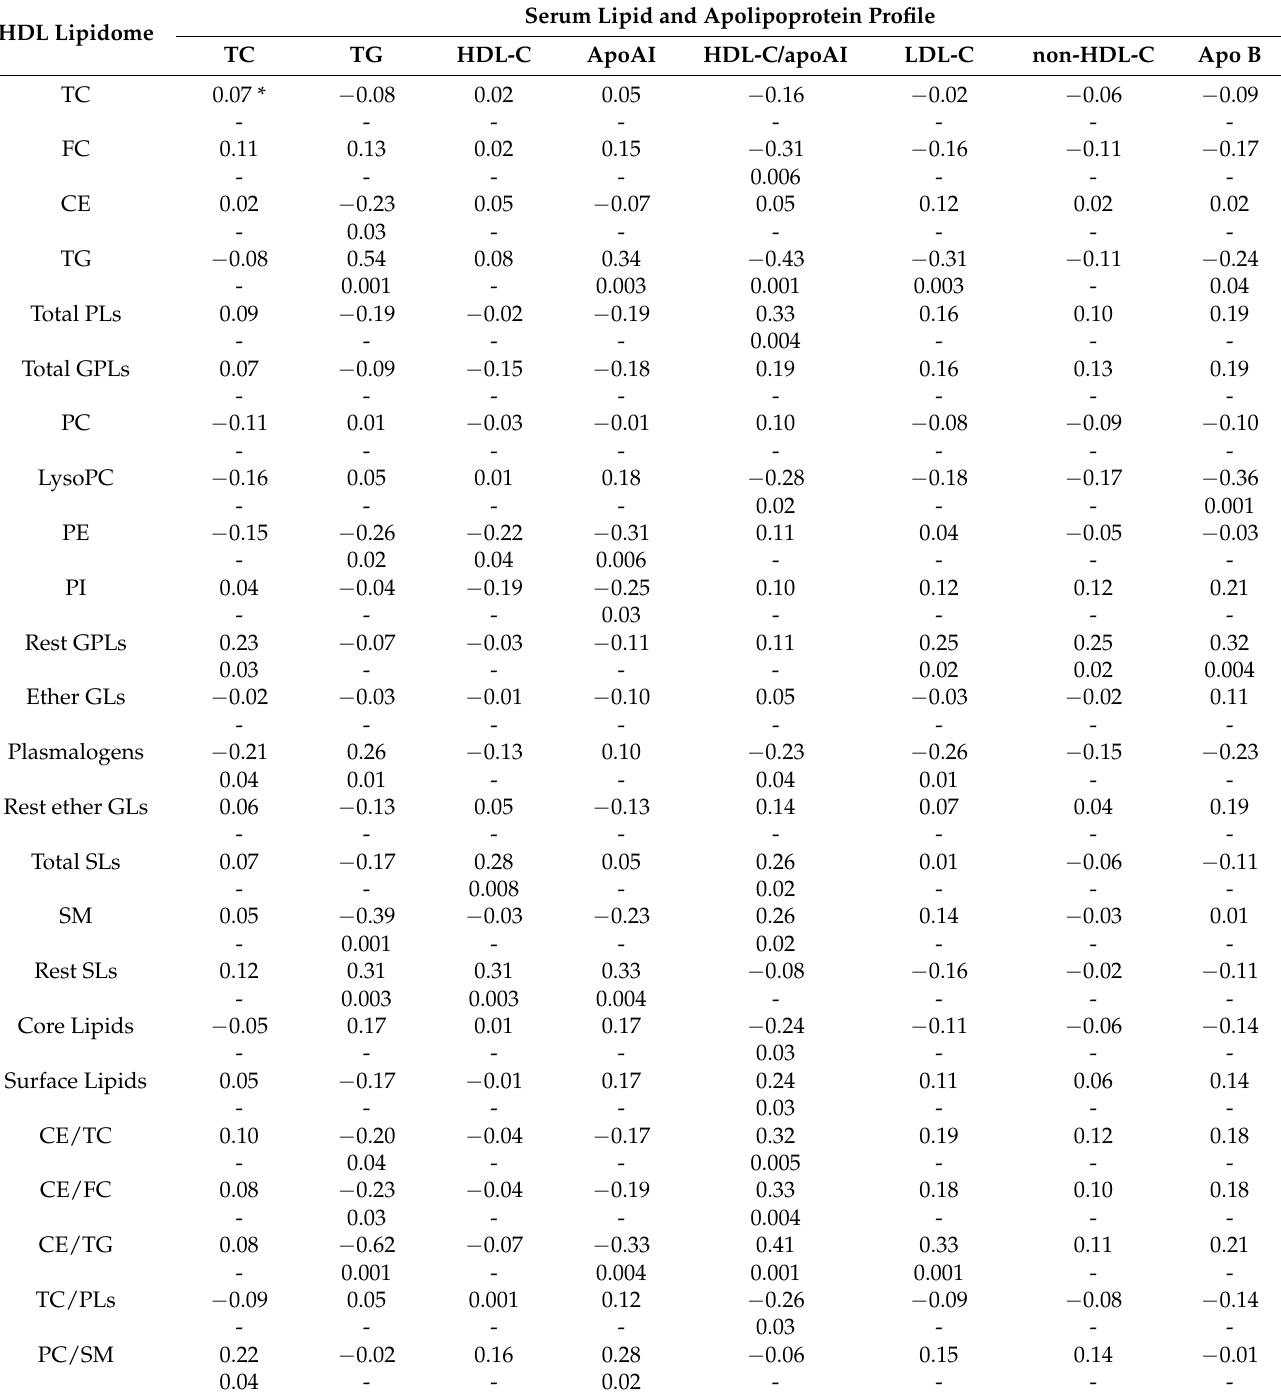
Table 4. Correlation between serum lipid and apolipoprotein parameters and HDL